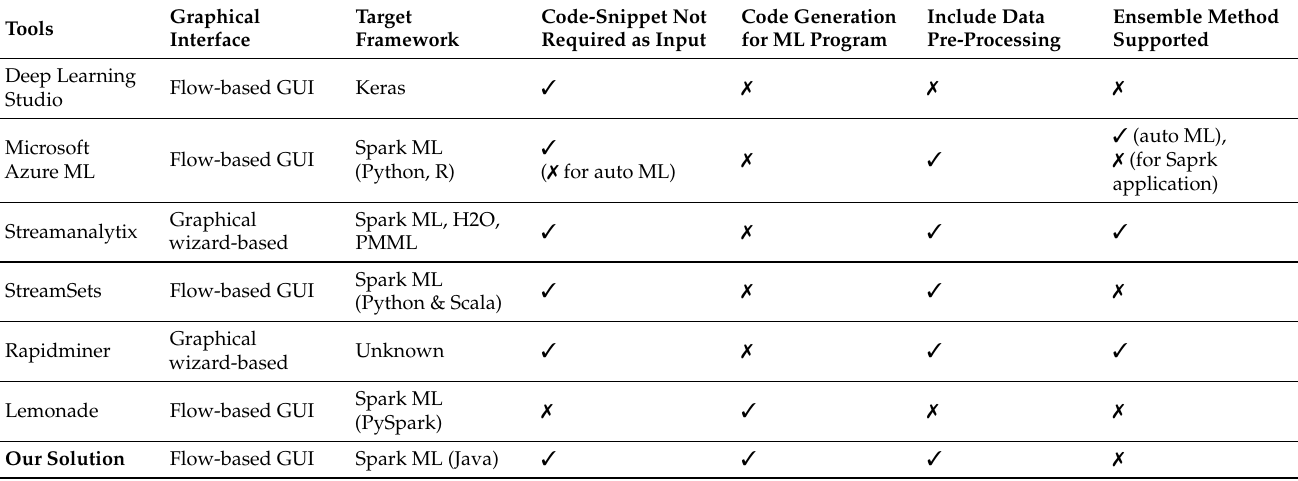
Table 3. Comparison of existing solutions with our approach to automate ML application